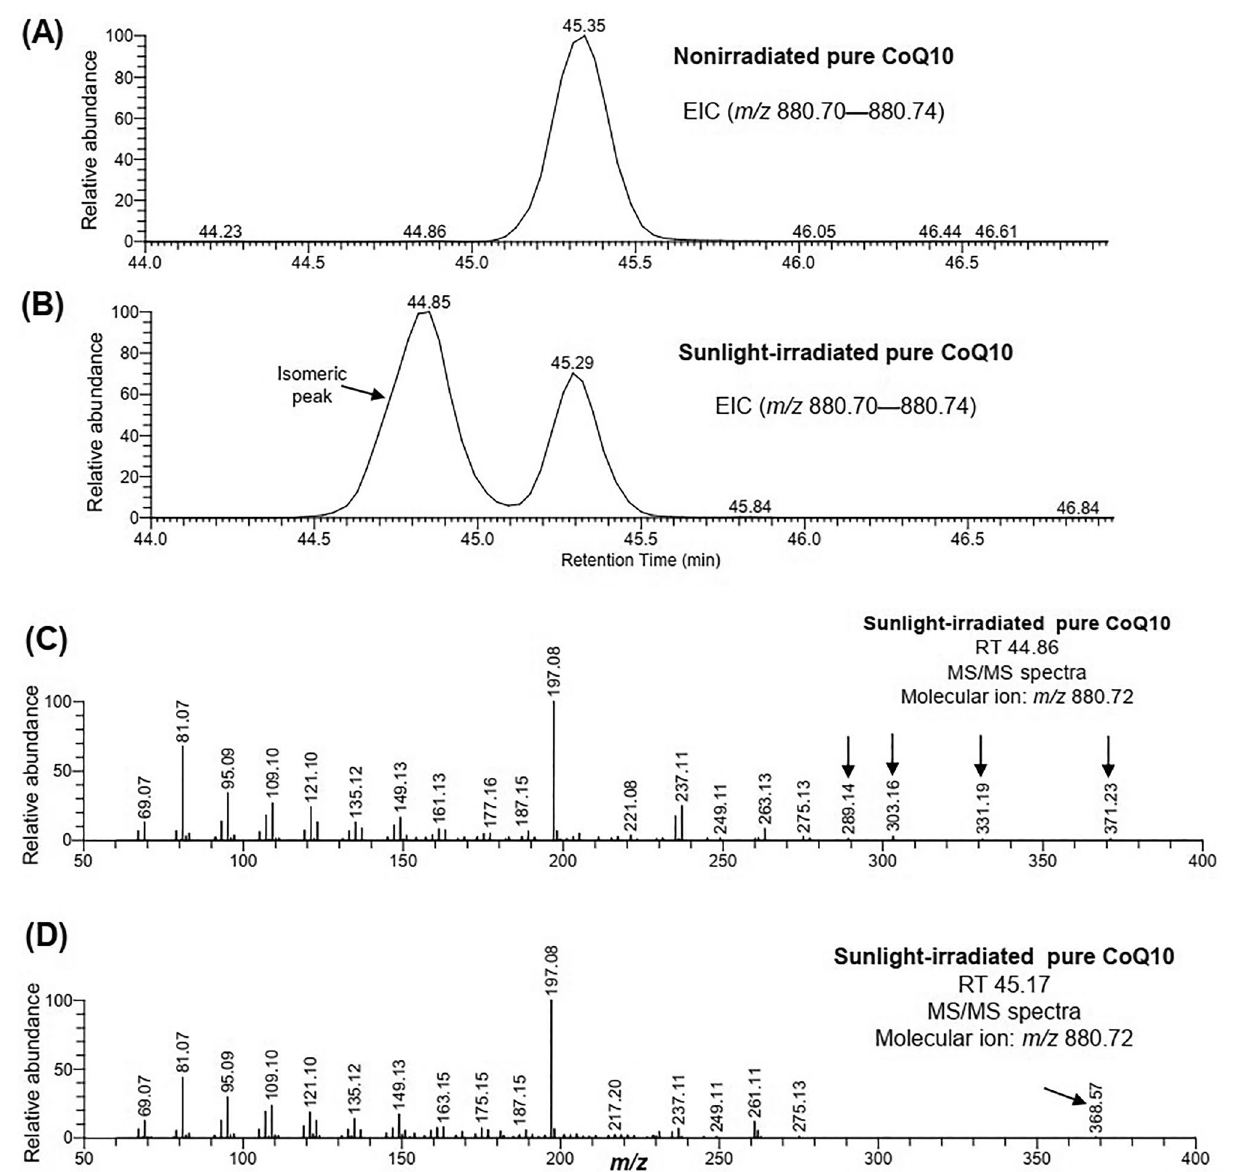
Figure 4. EIC and MS/MS spectra of pure coenzyme Q10 (CoQ10). EICs were observed in the ( A ) nonirradiated and ( B ) sunlight-irradiated samples. MS/MS spectra of CoQ10 at ( C ) RT 44.86 min and ( D ) RT 45.17 min in the sunlight-irradiated sample. Arrows indicate the fragmentations exclusively observed at RT 44.86 min or RT 45.17 (excluding the peak which generally appears at the beginning due to the elution of highly hydrophilic com- pounds that do not bind to the column) was mainly observed in the TIC of the nonirradiated pure CoQ10 (Fig. S4A). On the other hand, in addition to the peak at 45.3 min, a number of peaks were observed in the TIC of sunlight-irradiated pure CoQ10 (Fig. S4B), indicating that the isomerization and/or any other phenomena (e.g., degradation) of some CoQ10 molecules has occurred. Similar to the results of eyeball extract, an additional peak (at RT 44.8 min) at the left of the original peak (RT 45.3 min) was observed in the EIC of CoQ10 in the irradiated pure sample (Fig. 4B). Interestingly, the left peak of CoQ10 showed a larger area than the right peak. It is also noteworthy that the isomeric peak (at RT 44.8 min) of CoQ10 was the most prominent among the addi- tional peaks in the TIC of irradiated pure CoQ10 (Fig. S4, Fig. 4). The MS/MS spectra at two different RT showed a similar pattern with several characteristic fragment ions, which were exclusively observed at RT 44.86 min or 45.17 min (Fig. S5, Fig. 4C,D). These results indicated that pure CoQ10 was isomerized by sunlight irradiation. It is to be noted that CoQ10H2 was not detected in this data (Fig. S6), meaning that sunlight did not mediate the reduction of CoQ10 to CoQ10H2.